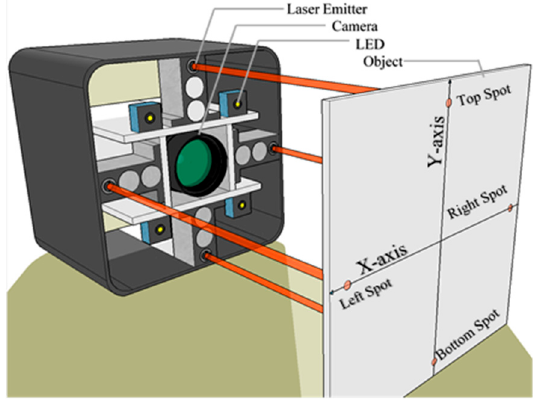
Figure 2. Three-dimensional design of the system.